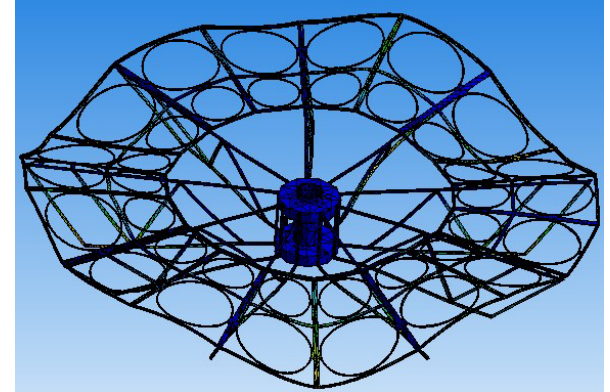
Figure 8. First-order mode shape of free vibration.